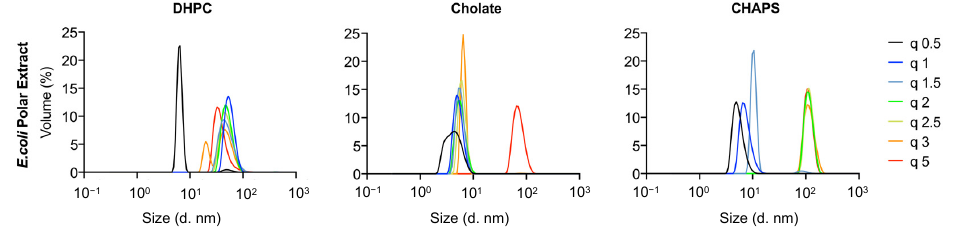
Figure 6. DLS size distribution of mixtures of DHPC, cholate, and CHAPS with an E. coli polar lipids extract. The curves are representative of one to three independent experiments.